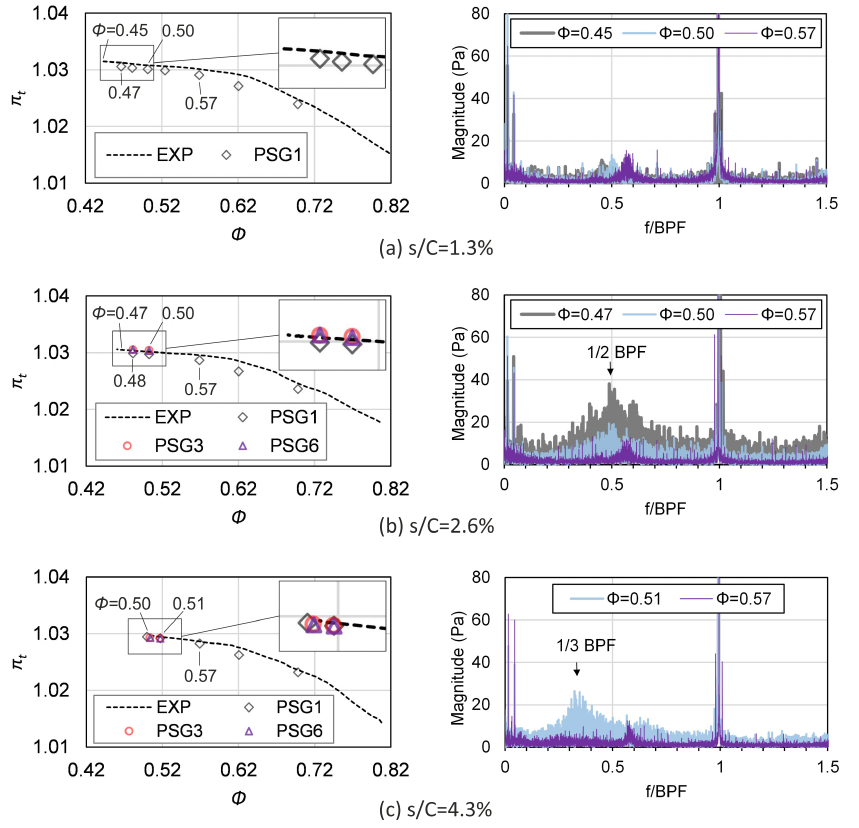
Figure 4. Compressor characteristics and experimental FFT spectra of wall pressure for sensor A. Radial distributions of relative flow angle ( β ) and circumferential-averaged axial velocity ( c a ), with the latter normalized by ¯ c a , are available from the five-hole probe mea- surements. The measured data and the predictions are compared in Figure 5. Regardless of the variation of the tip gap, the distributions of β and c a /¯ c a are well simulated. The